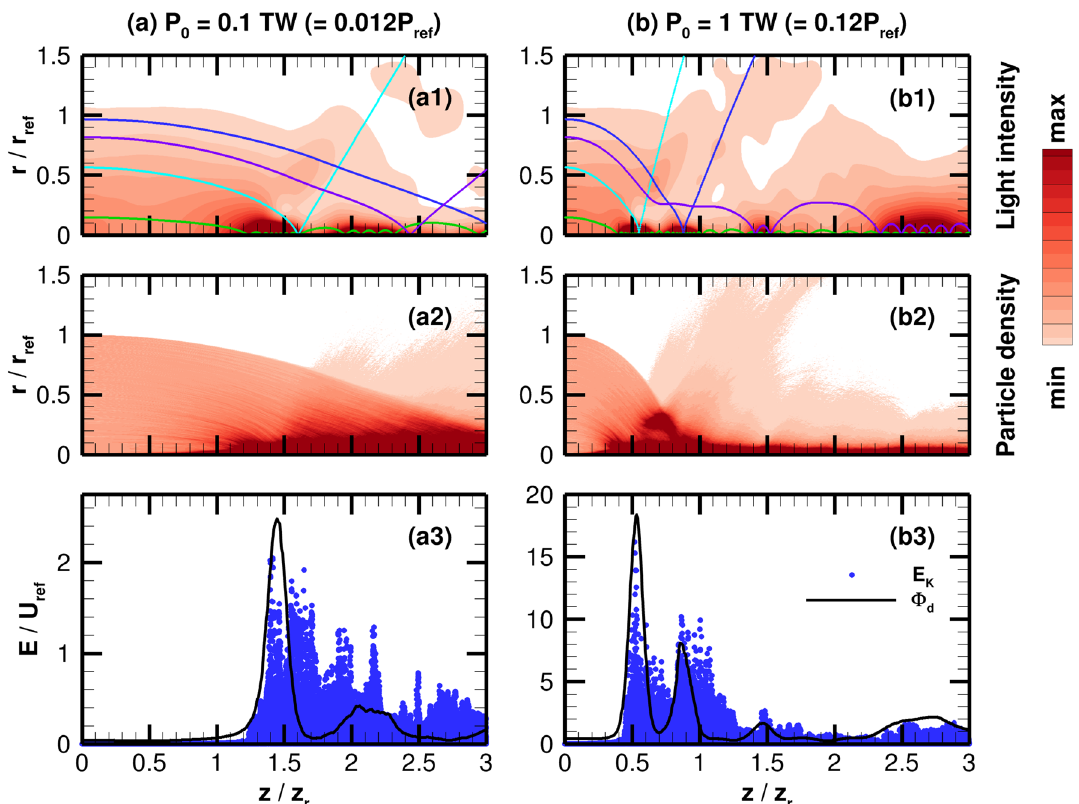
Figure 8. Beam propagation in the absence of the scattering force, i.e., only dipole force is considered, and zero particle temperature for a light beam power of ( a ) 0.1 TW and ( b ) 1 TW. The over-focusing effect is demonstrated through (a1, b1) the normalized light intensity with four representative particle trajectories and min and max values corresponding to 0.1 and 2.5, (a2, b2) the normalized particle density with min and max values corresponding to 0.1 and 4, and (a3, b3) the radial kinetic energies, E K , of the particles compared with the depth of the light potential well, (cid:31) d , at each axial location. The energies, E , are normalized by U ref = 2.76 × 10 − 24